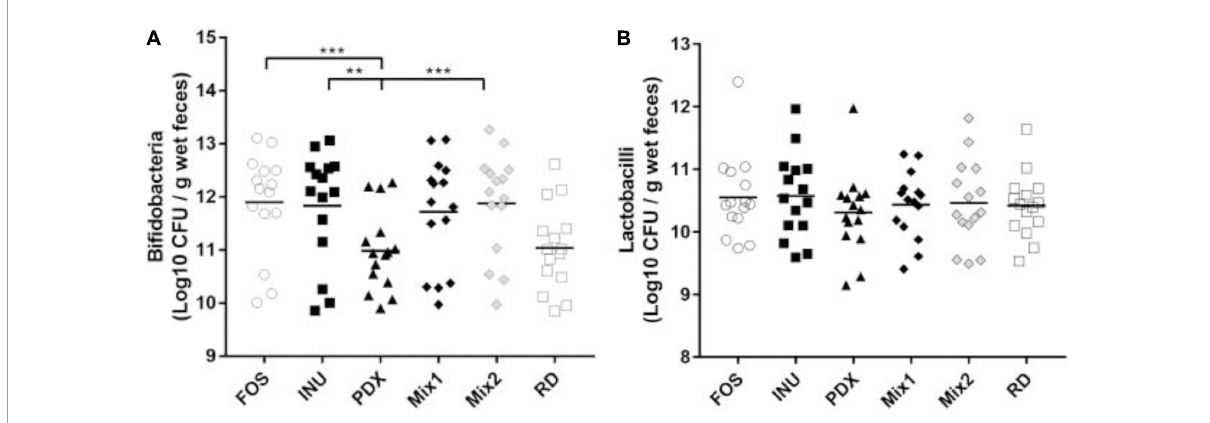
FIGURE3 Comparison of Bifidobacteria spp and Lactobacilli spp after 24h in vitro fermentation. The amounts of Bifidobacteria spp. (A) and Lactobacilli spp. (B) in the fermented broth of each carbohydrate were determined by qPCR. The data of fifteen volunteers were shown in scatter dot plot, line is at the mean. Only the significant differences between inulin (INU) and PDX were shown. ** p value < 0.01, *** p value <